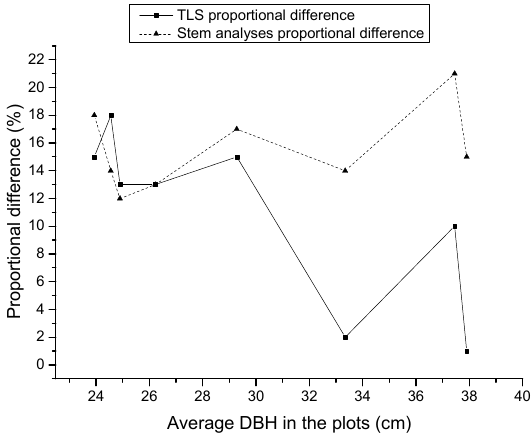
Table 8. Predicted total volume, including bark, ranked by DBH.